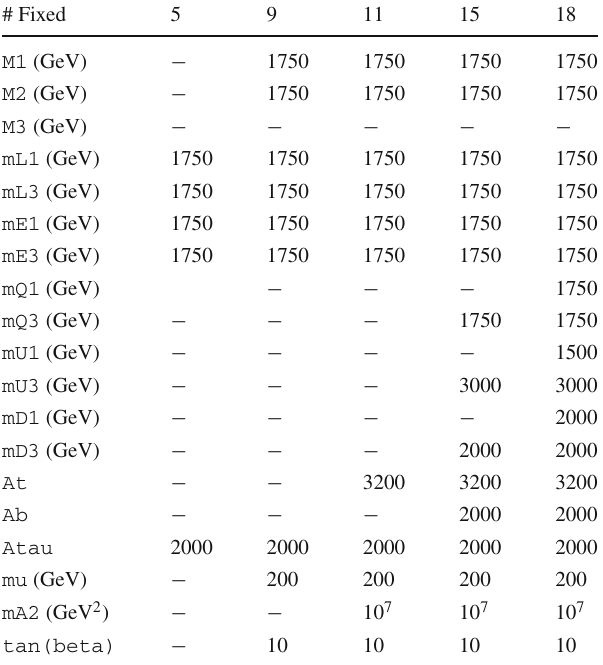
Table 1 List of parameters of the 19-dimensional pMSSM in the reduceddimensionalityexperiments.Parameterswithafixedvaluehave this value denoted in the respective column. Parameters that are left free are indicated by a